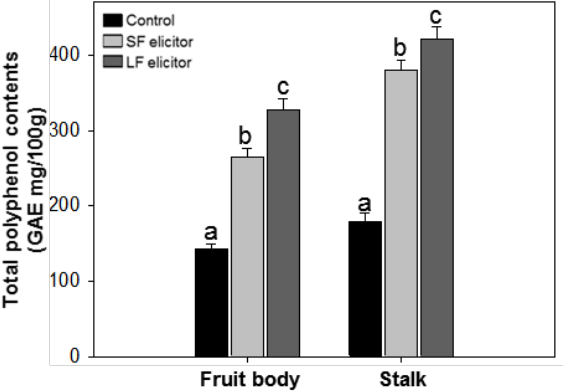
Figure 4. Total polyphenol contents of aqueous extracts of Sparassis latifolia after alginate elicitation. SF: Solid fraction of Sargassum fusiforme ; LF: Liquid fraction of S. horneri ; Control: distilled water. The data were analyzed using analysis of variance (ANOVA) followed by Duncan’s multiple-range test ( p < 0.05) using SPSS software (SPSS, Chicago, IL). Error bars indicate the mean ± SD and different letters describe greater differences within the same part of S. latifolia (fruit body and stalk).